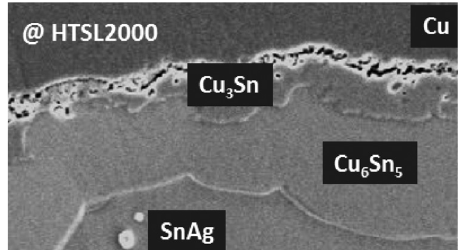
Figure 14. Zoom in section for Ni-free pillar at HTSL